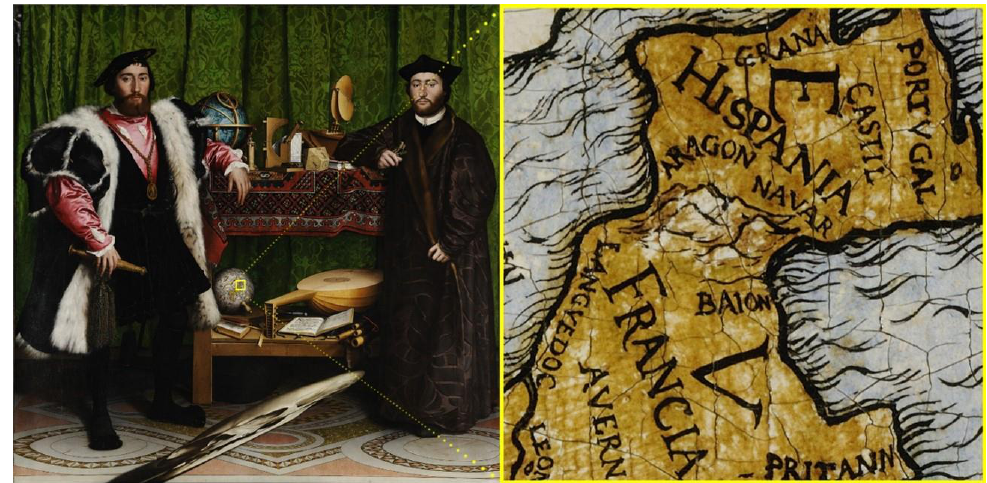
Figure 1. Hans Holbein the Younger, 1533, The Ambasssadors . Picture and detail obtained from Google Arts and Culture [2].